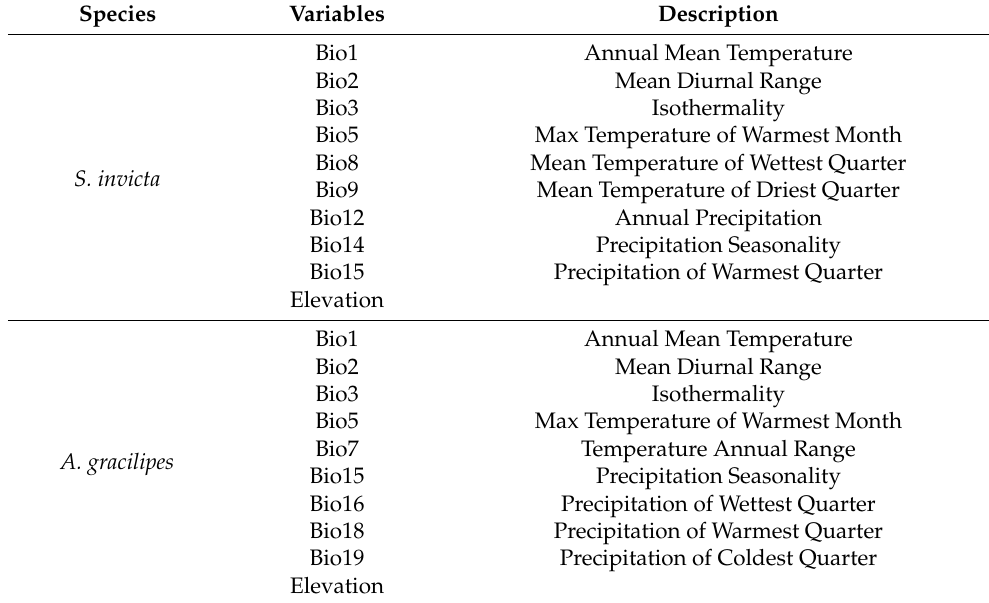
Table 1. Selected model variables for each